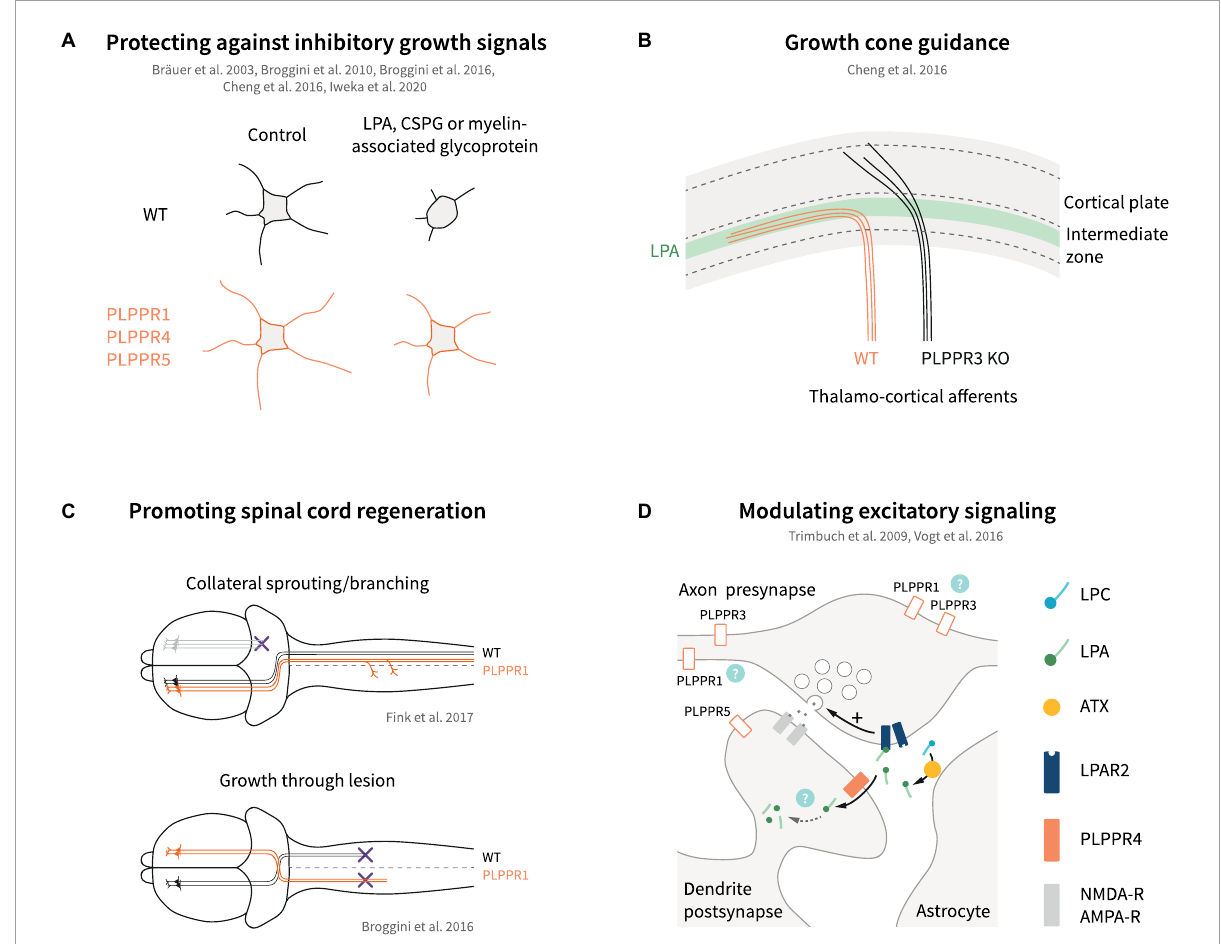
FIGURE5 Models of PLPPR modulation of neuronal growth, guidance, regeneration and excitatory signaling. (A) Overexpression of several PLPPRs overcomes neuronal growth inhibition mediated by established inhibitory signals (LPA, CSPGs, myelin-associated glycoprotein). (B) PLPPR3 alters LPA-sensitivity of thalamocortical neurons to enter the developing cortex, thereby affecting axon guidance. (C) PLPPR1 overexpression improves re-innervation of neuron in the corticospinal tract in spinal cord injury models by increasing branching in uninjured neurons and by promoting extension of axons through the lesion. (D) PLPPR4 affects neurotransmitter release at excitatory synapses by reducing available LPA to act on presynaptic LPA-receptors. Possible roles of other PLPPRs are highlighted by question marks. For details, please refer to